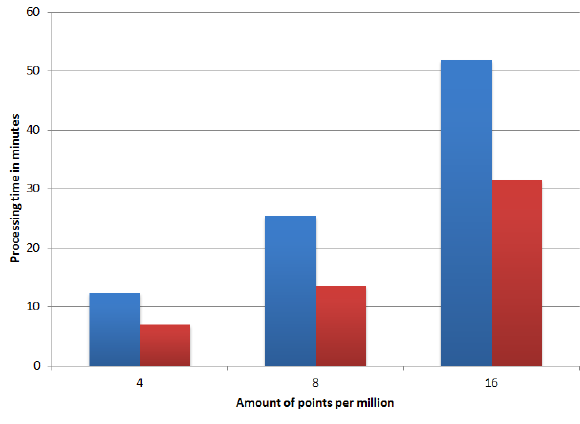
Figure 10. Trajectory voxels are represented in red, seed voxels are represented in blue per trajectory ID. The black line represents a split in the data for visualization purposes can only be found when there is enough distance between the top of the door and the ceiling, is not yet implemented in an automatic way and doors can only be crossed during the data capture.